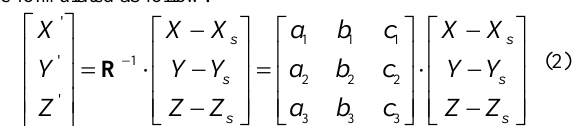
Figure 1. The descent images of Chang’e-4